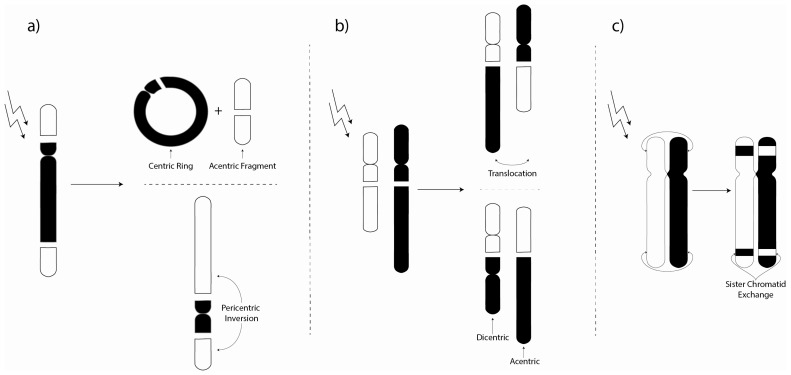
Examples of (a) intra-chromosomal aberrations (including pericentric inversions and the formation of centric rings and acentric fragments); (b) Inter-chromosomal aberrations (including translocations and the formation of dicentric and acentric fragments); and (c) Sister chromatid exchange (whereby genetic material is exchanged between two sister chromatids).